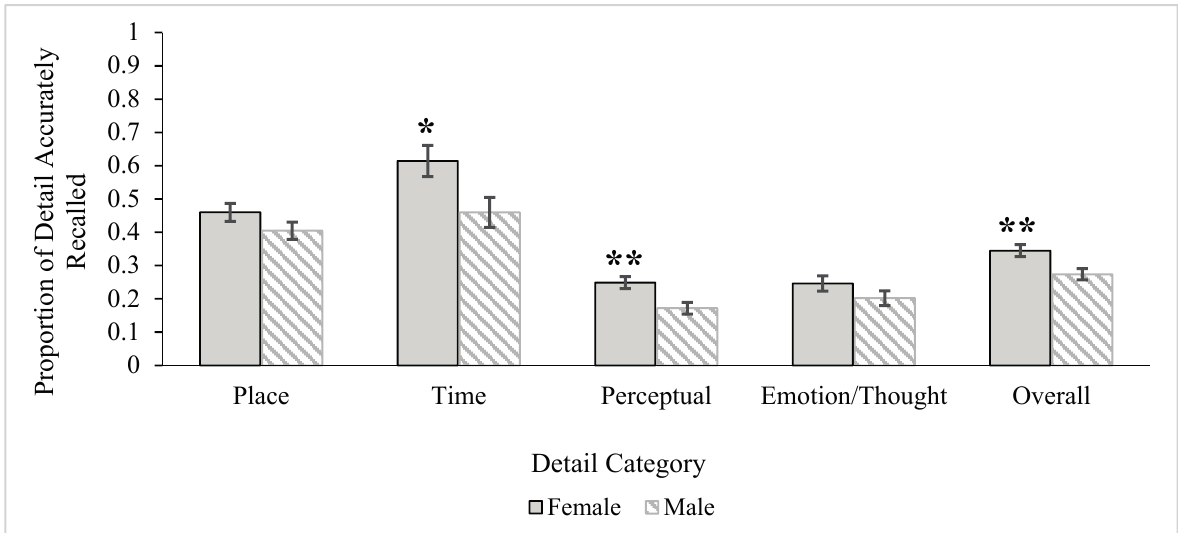
Figure 3. Gender differences for accuracy of overall detail and detail categories. Error bars represent ± 1SE. Single asterisk marks significant effect at the p < 0.05 level and double asterisks mark significant effects at the p < 0.01 level. Gender differences for overall gist remained significant after including covariates (episodic memory, education) in the model, but multivariate effects ( time and perceptual ) became